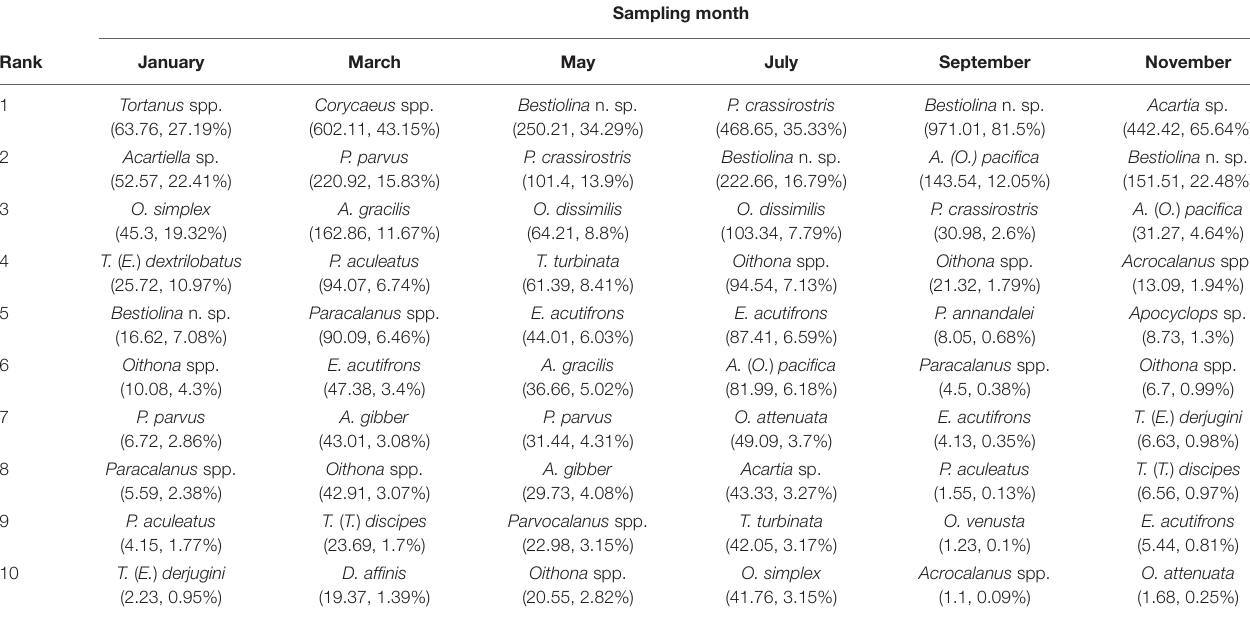
TABLE 2 | Average density (individuals m − 3 ), and relative abundance (RA, %) of the 10 most abundant copepod species recorded on each bimonthly sampling date in